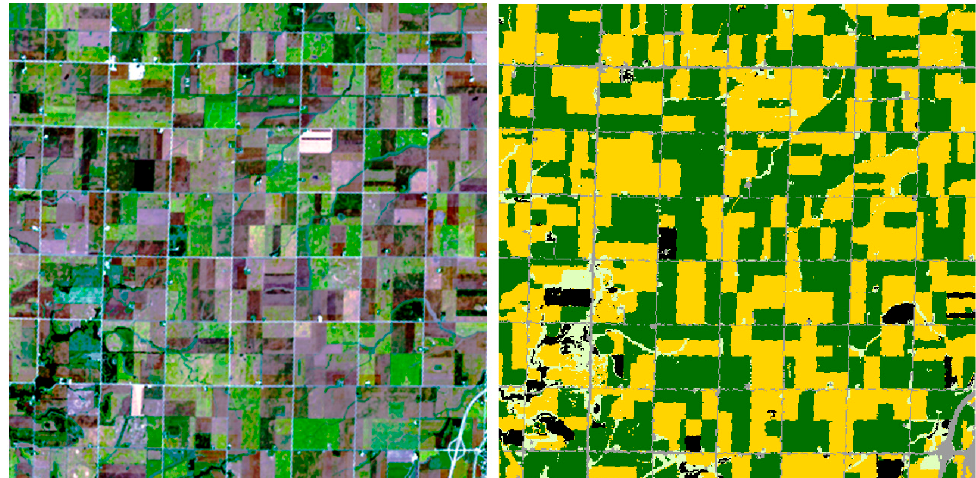
Figure 2. Illinois (400 × 400 pixels). Bright green = soybeans (43.43%); yellow = corn (43.98%); gray = developed or open space (5.29%); pale green = grass/pasture (4.60%); black = background (CDL classes corresponding to ≤ 2% of the study area).